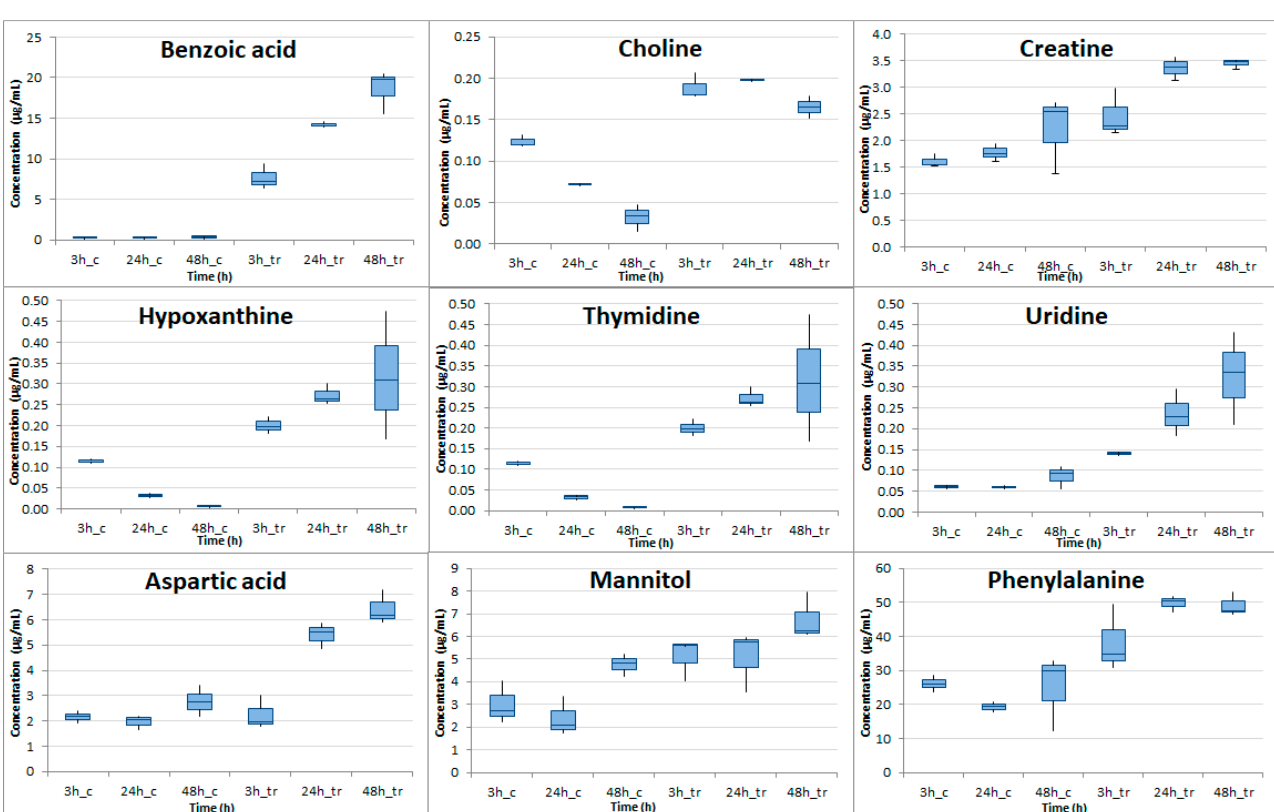
Figure 5. Boxplots presenting the concentrations of compounds with p < 0.05 at least at 24 h and 48 h in the cell medium of cocaine-treated HepG2 cells compared to control HepG2 cells (c stands for control, tr for cocaine-treated cells).